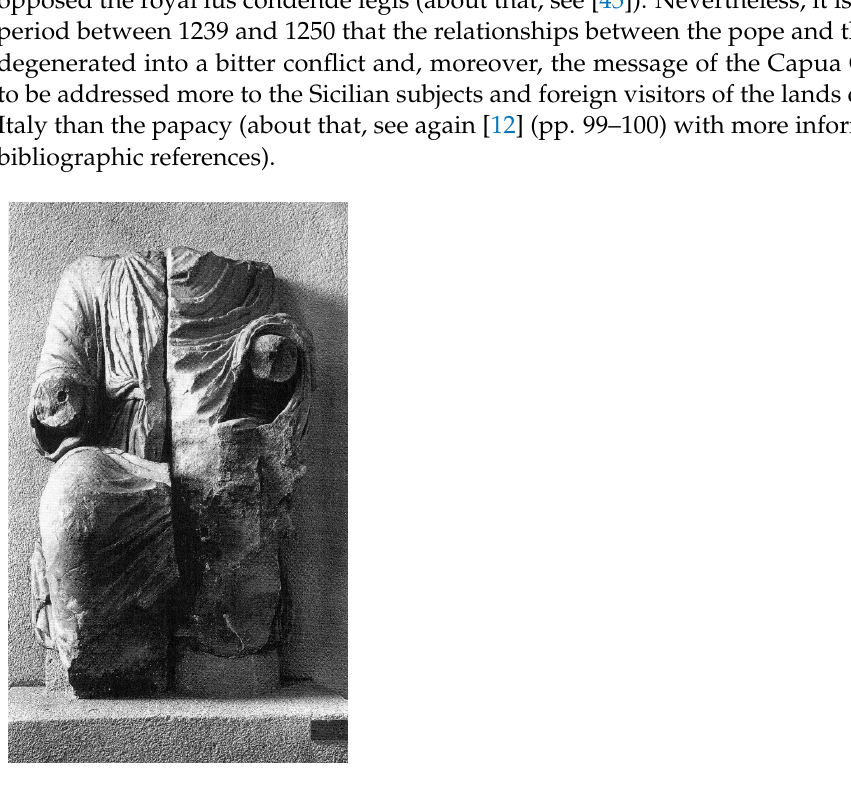
Figure 5. Headless statue of Frederick II, sculpture, from the façade of the Capua Gate, 1234–1247. Capua, Museo Provinciale Campano. Image published in [12] (Figure 24).